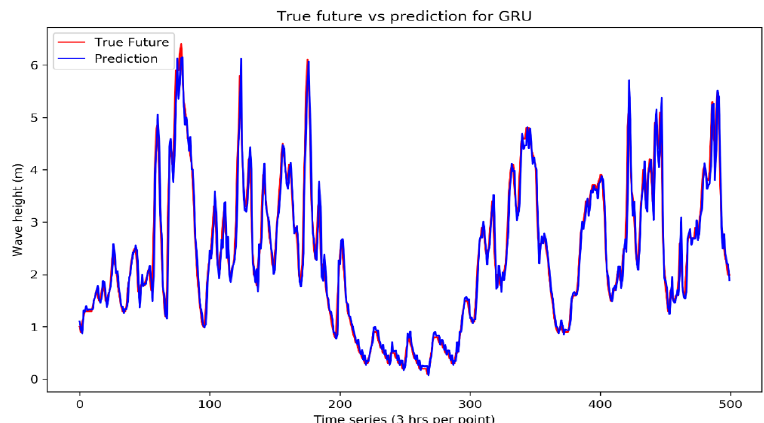
Figure 19. GRU wind speed prediction.